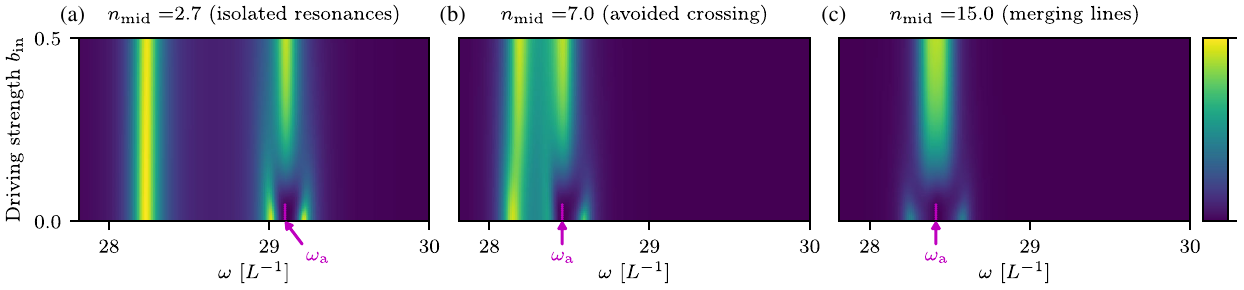
FIG. 13. Nonlinear spectra as a function of the driving strength, corresponding to each of the regimes in Fig. 12. (a) – (c) show results 2 . 7 , 7.0, and 15.0, respectively. The cavity is driven from one side, such that b ð in Þ ¼ b for n mid ¼ 0 , the spectrum coincides with the linear interaction spectra shown in Fig. 11(b) at each n transmission spectra are shown. At b in ¼ At large b , the corresponding empty cavity spectra in Fig. 11(a) are approached due to saturation of the atom excitation. The atom in resonance frequency for each spectrum is chosen as before and is indicated by the magenta